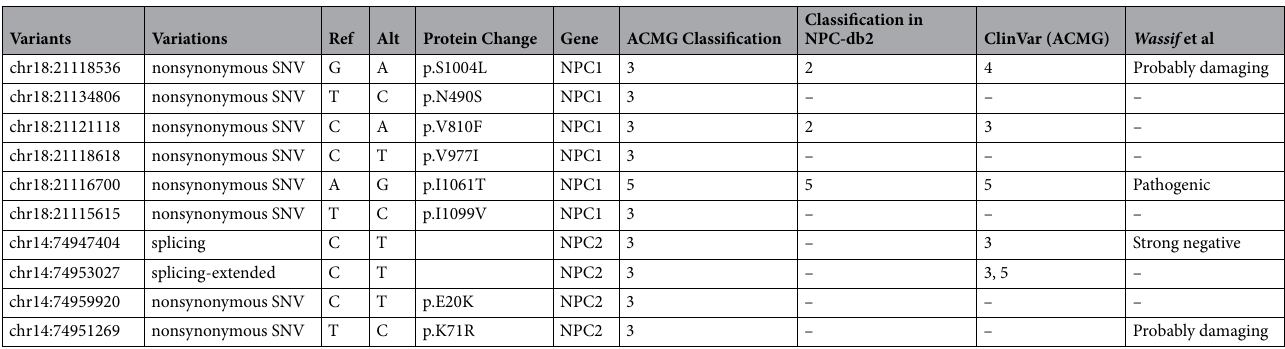
Table 4. Rare variants in CARTaGENE sample, exome-seq. a Classification 1: Benign 2: Likely benign 3: Uncertain significance 4: Likely pathogenic 5: